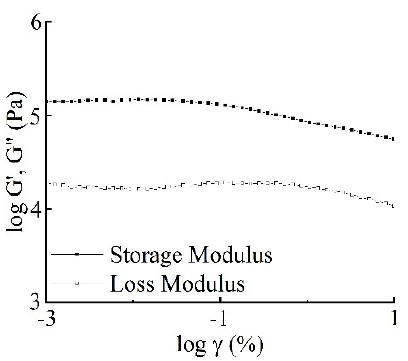
Figure 9. Storage (G’) and loss modulus (G’’) as a function of strain at 25 °C.